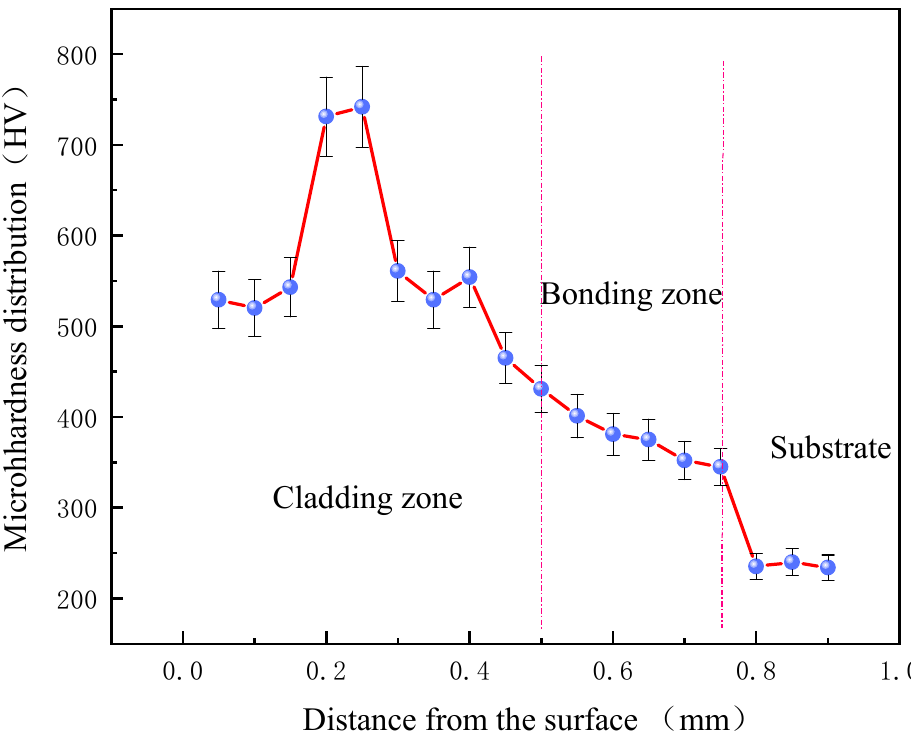
Figure 11. The microhardness curve of the coating.